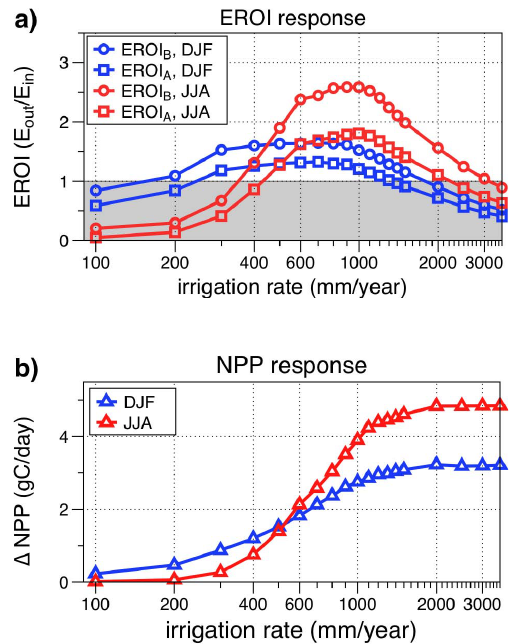
Fig. 1. (a) EROI A and EROI B , and b) NPP, both shown as a function of the irrigation rate and averaged over the entire irrigation region. The seasonal mean for December–February (DJF) is shown in blue, and the seasonal mean for June–August (JJA) is shown in